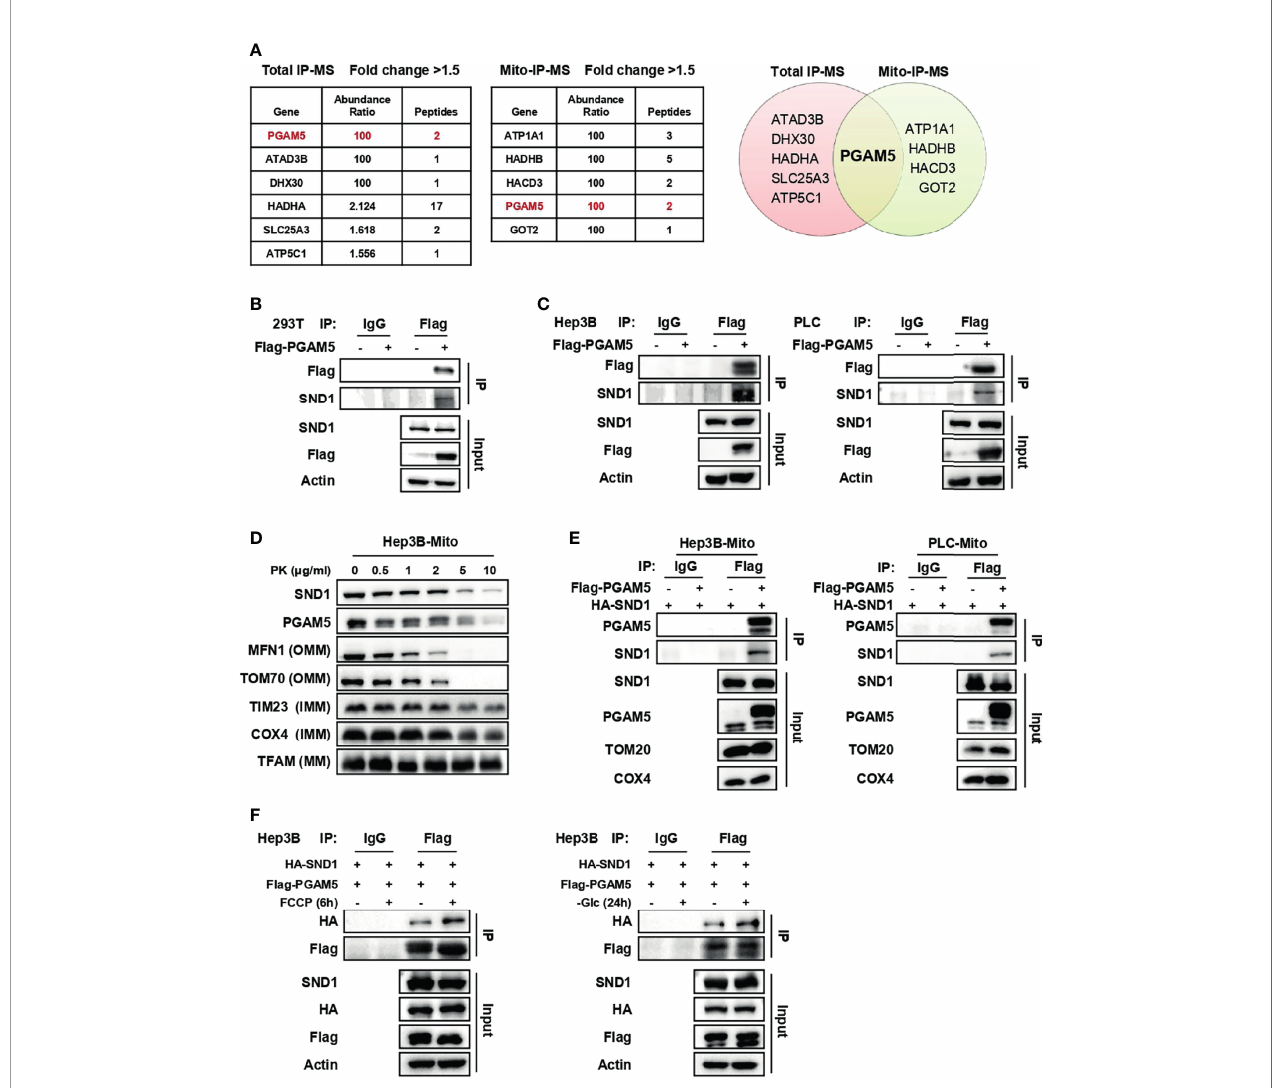
FIGURE 3 | SND1 binds to PGAM5 in mitochondria. (A) Proteins bound by SND1 with a fold change > 1.5 compared to the EV control group in total IP-MS or mitochondrial IP-MS results (left). Venn diagram showing the overlap of proteins bound by SND1 from total IP-MS and mitochondrial IP-MS results (right). (B) 293T cells were transfected with Flag-EV or Flag-PGAM5 plasmids. Cell lysates were immunoprecipitated with anti-Flag antibody, followed by immunoblotting analysis with antibodies against Flag and SND1. Actin served as loading control. (C) Hep3B cells (left) or PLC cells (right) stably expressing Flag-PGAM5 were harvested and subjected to Co-IP analysis. Cell lysates were immunoprecipitated with anti-Flag antibody, followed by immunoblotting analysis with antibodies against Flag and SND1. Actin served as loading control. (D) Protease protection assays performed on puri fi ed mitochondria isolated from Hep3B cells. Enriched mitochondria were digested after incubation with proteinase K at the indicated concentrations and the localization of PGAM5 was analyzed by immunoblotting. MFN1/TOM70, TIM23/ COX4, and TFAM were used as markers of OMM, IMM, and MM, respectively. (E) Hep3B cells (left) or PLC cells (right) stably expressing HA-SND1 were further infected with viruses expressing Flag-EV or Flag-PGAM5, and then Co-IP assays were performed using an anti-Flag antibody in enriched mitochondrial fractions, followed by immunoblotting analysis with antibodies against PGAM5 and SND1. TOM20 and COX4 served as loading control. (F) Hep3B cells stably expressing HA- SND1 were further infected with viruses expressing Flag-PGAM5, and then treated with FCCP for 6 h (left) or glucose-free medium (right) for 24 h. Cells were harvested and cell lysates were subjected to Co-IP analysis using an anti-Flag antibody, followed by immunoblotting analysis with antibodies against HA, Flag, and SND1. Actin served as loading